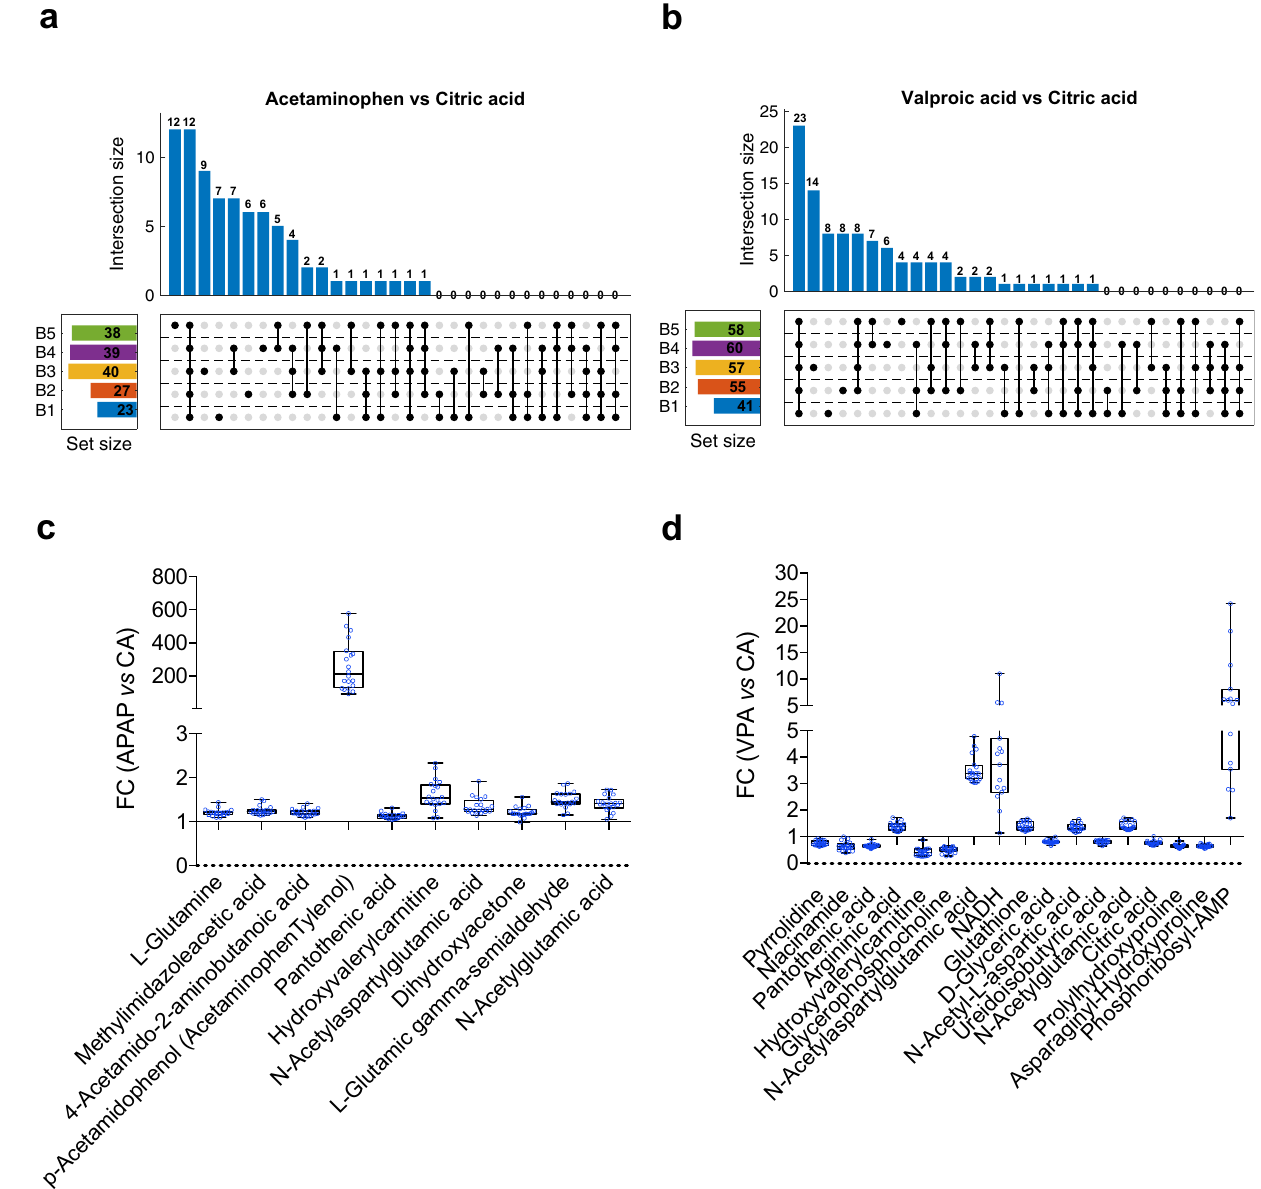
Figure 4. Analysis of the reproducibility of the metabolic alterations induced by xenobiotics. Upset plots to visualize the intersecting sets of metabolites that appeared statistically significant ( p value < 0.05) in the t test analysis between acetaminophen and citric acid ( a ) or valproate and citric acid ( b ) from one up to five batches. Numbers on the set size squares indicate the metabolites that are statistically significant between compound comparisons in each batch. ( c - d ) Box plots of the fold change (FC) in the levels of the metabolites that were statistically significant in the t test between valproate or acetaminophen treatment versus citric acid in all five batches. FC > 1 means metabolite increase and FC < 1 decrease. Each dot represents the FC in a specific batch and